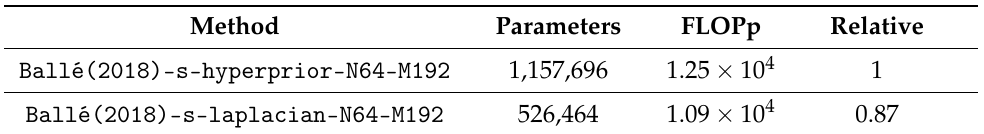
Table 4. Reduction of the encoder complexity induced by simplified entropy model on the coding part-Case of rates up to 2